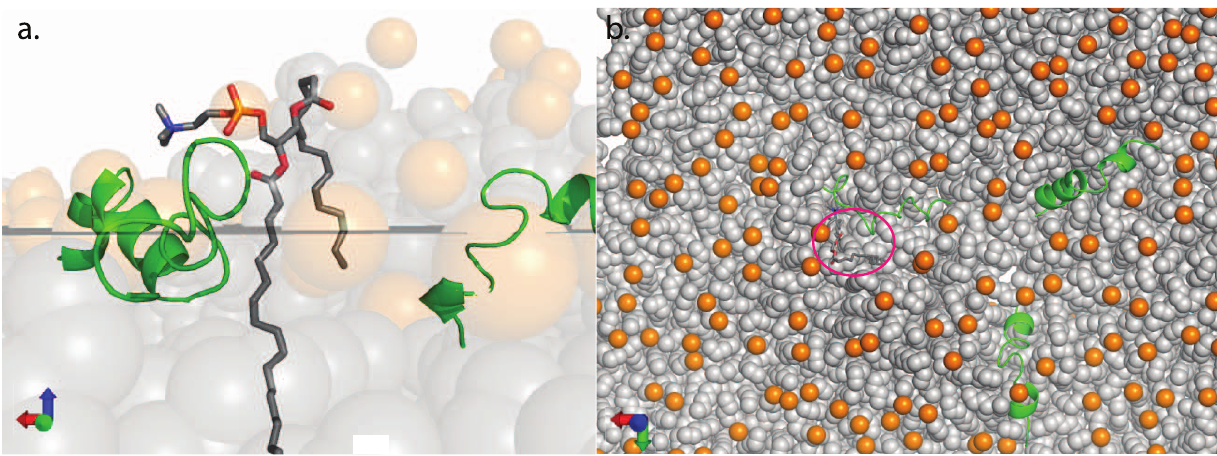
Figure 1. Lipid tail protrusion. This simulation snapshot is shown in side (a) and top (b) views and highlights one lipid, rendered in sticks, with an acyl tail protruding into the polar layer. One acyl tail of this lipid is bulging into the polar layer, extending . 1 A˚ past its phosphorus atom and constituting what we classify as a protrusion event. The lipid is located near a fusion peptide (green). Other lipid tails are shown in gray spheres and other phosphates in orange spheres. A thin gray plane shows the average phosphorus position in the upper leaflet [46]. The fusion peptides are membrane-inserted but sit in a local undulation of the bilayer, hence the local abundance of lipids above the average z -position.